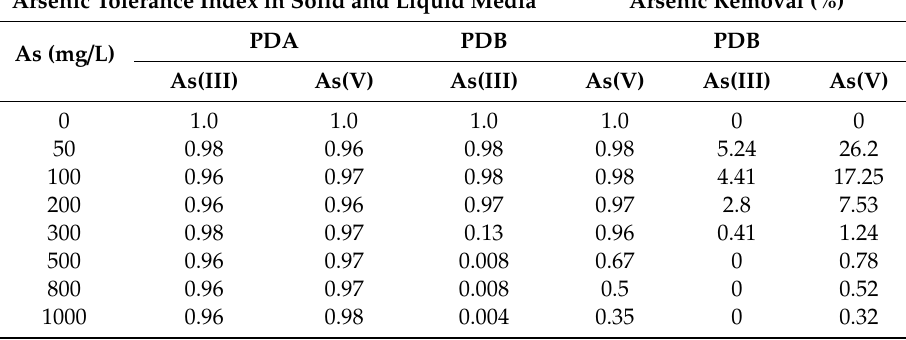
Table 1. Arsenic tolerance index for Talaromyces sp. KM-31 at varying concentrations of As(III) or As(V) in PDB and PDA media after 15 days of cultivation, and arsenic removal rates in PDB medium.